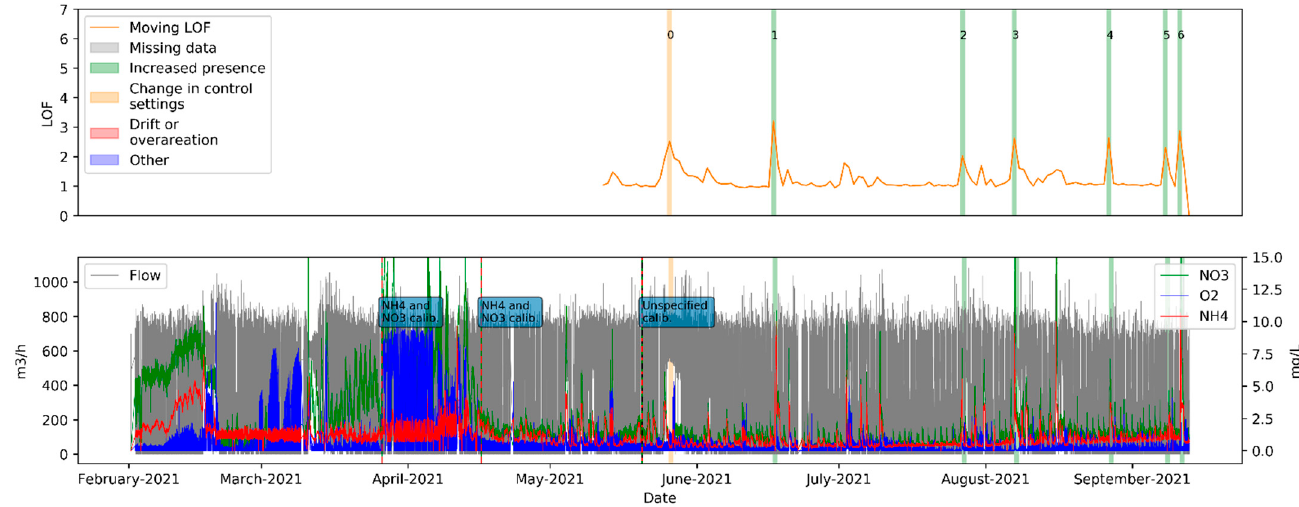
Figure 8. WWTP3 PCT1 In the upper graph the orange line shows the Moving LOF and the coloured areas, numbered from 0 to 6, show anomalies detected when the Moving LOF exceeded the threshold of two. The lower graph shows the flow, NO 3 , DO and NH 4 and calibration data available from the plant.